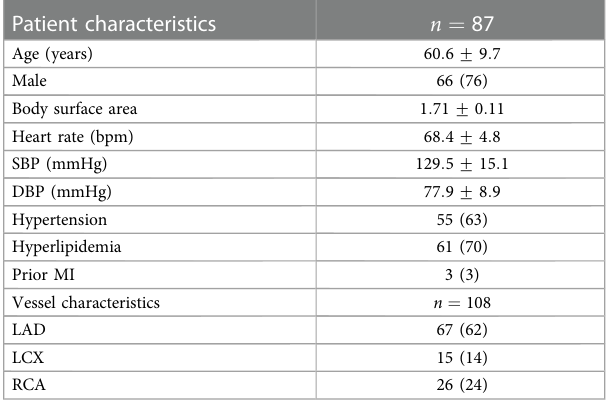
Table 1 . The average times for IVUS-FFR and FFR-branch were 3 and 20 min, respectively. TABLE 1 Baseline clinical characteristics.